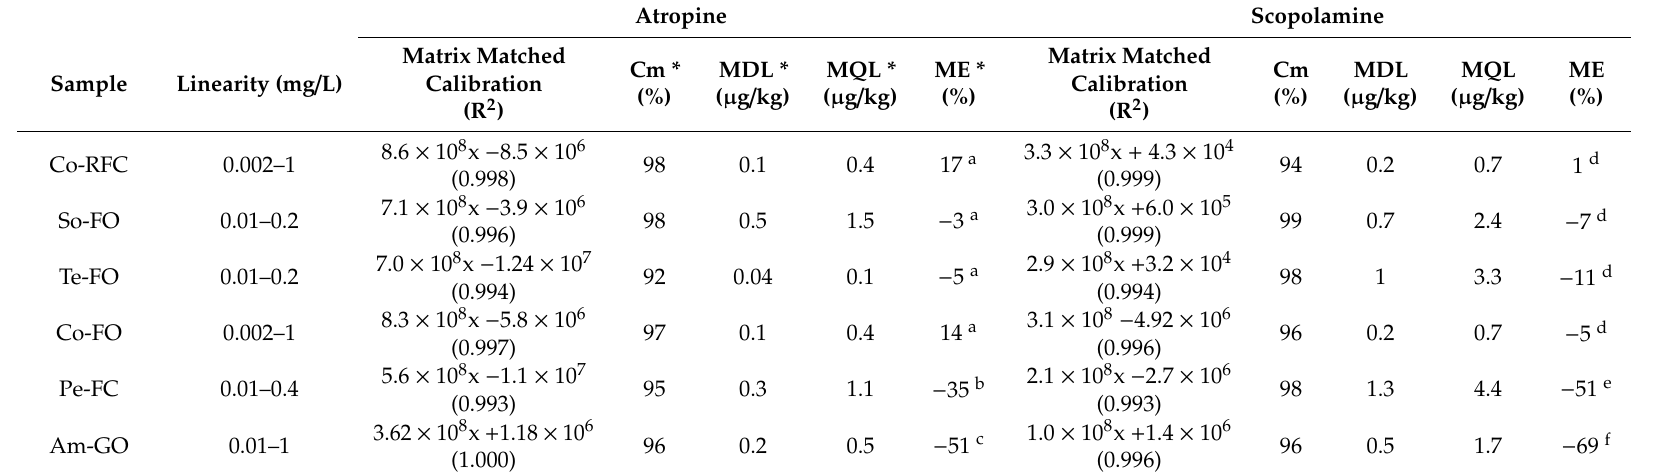
Table 4. Linearity, matrix e ff ect and limits for atropine and scopolamine in di ff erent